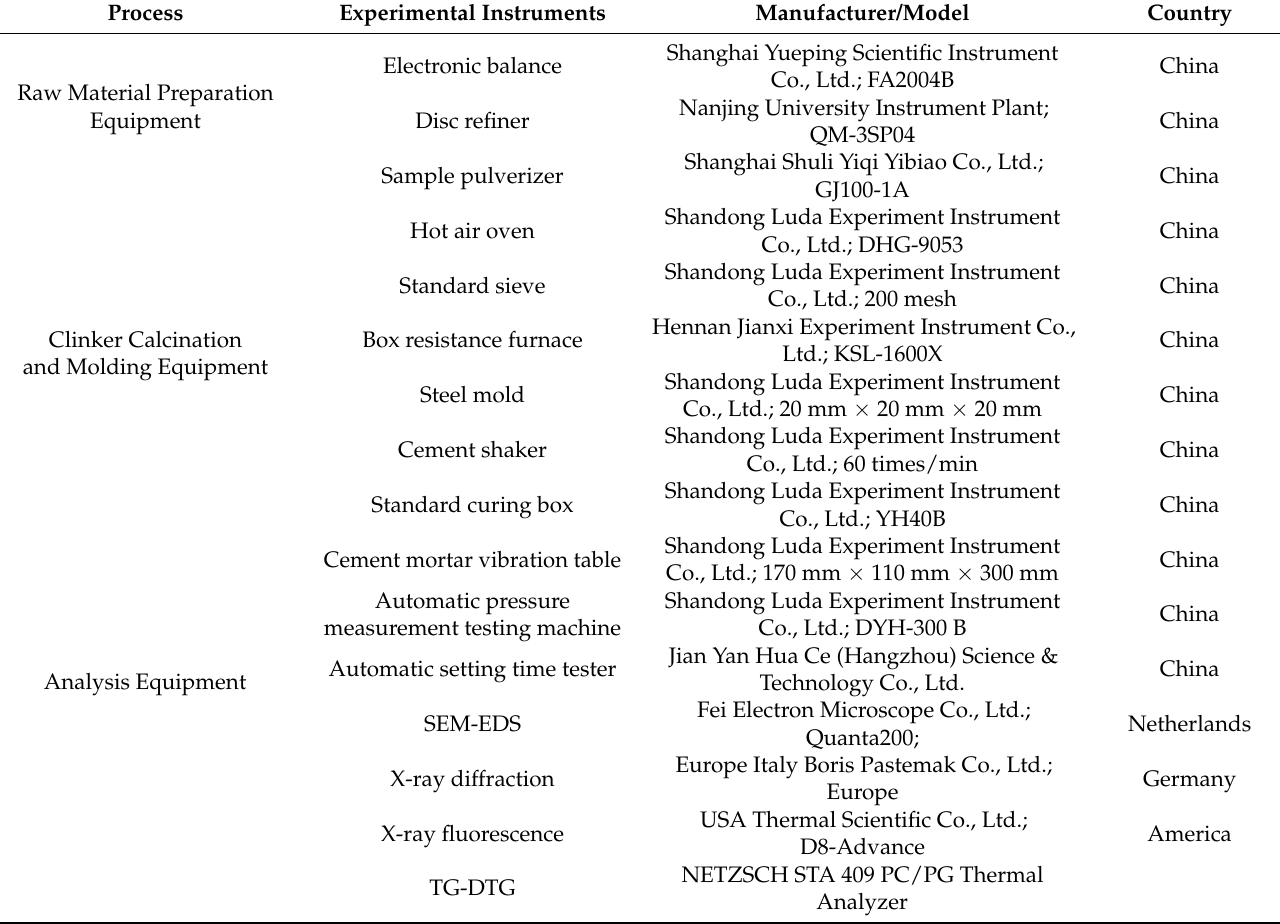
Table 1. Main pieces of experimental